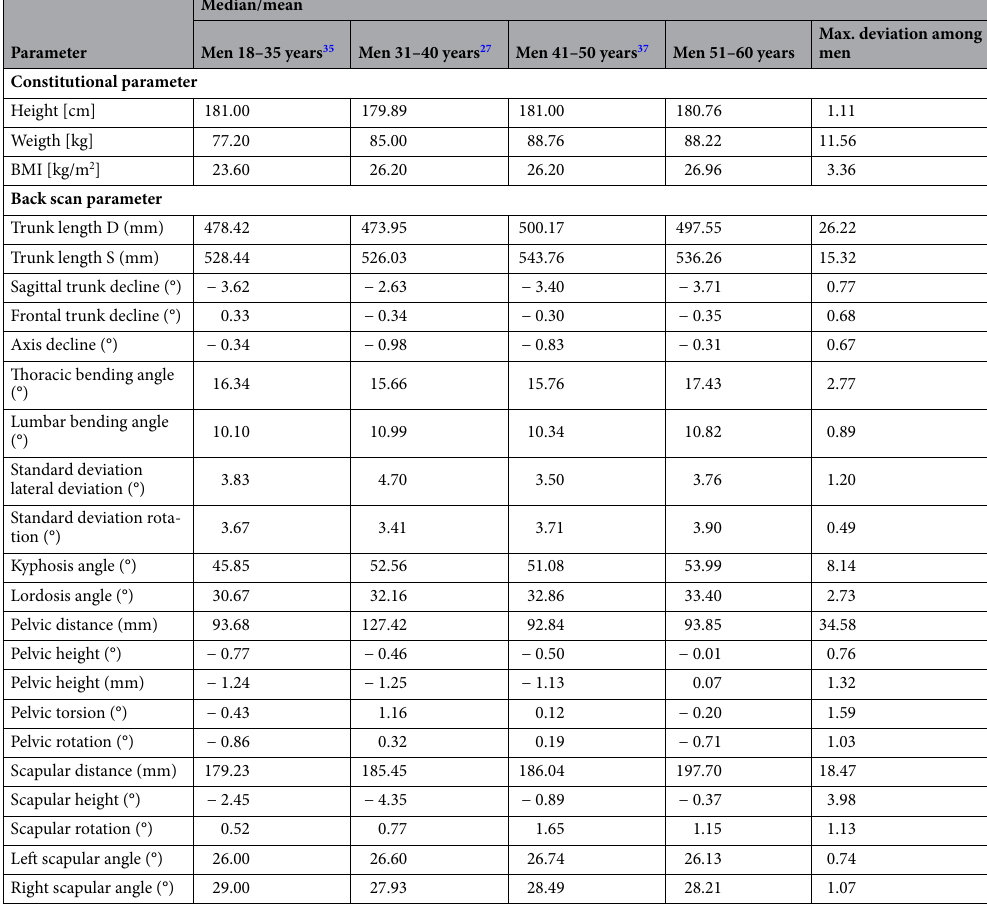
Table 3. Comparison of the median and mean values of the constitutional parameters and back parameters of different male age groups from the research of Ohlendorf et al. Values are taken from this work and research papers 27,35,37